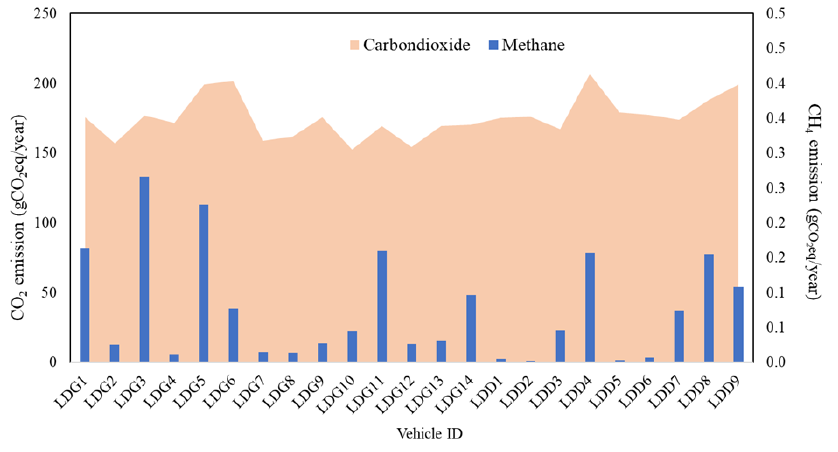
Figure 5. The CO 2 and CH 4 emissions (gCO 2 eq/year) from LDVs.